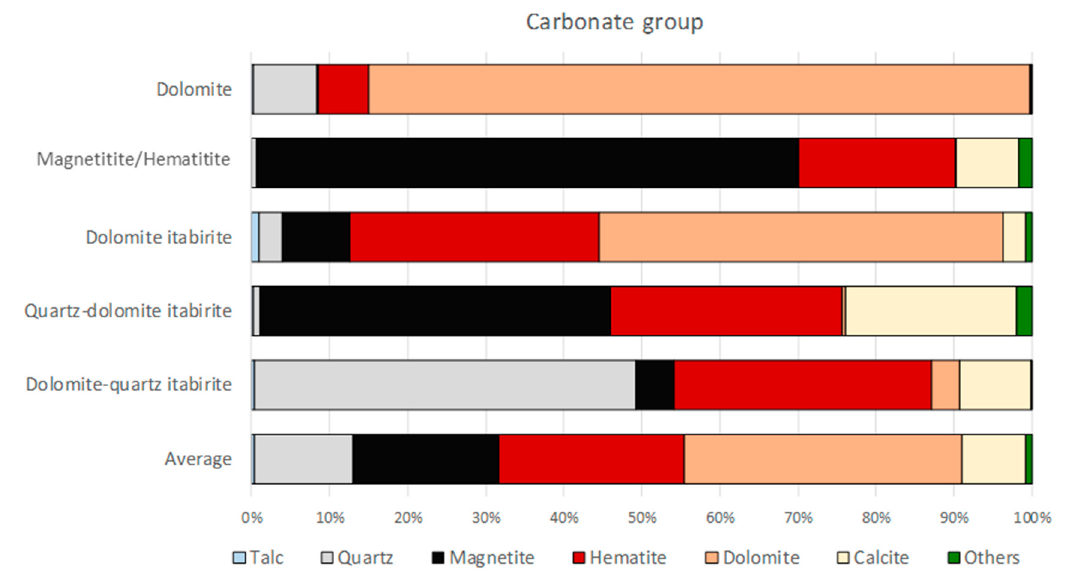
Figure 8. Average mineral proportions (wt. %) by XRD/Rietveld—unweathered (carbonate) materials. For the weathered group, the mineral assembly obtained via XRD contains hematite, quartz, and goethite as the main components, in different proportions. The